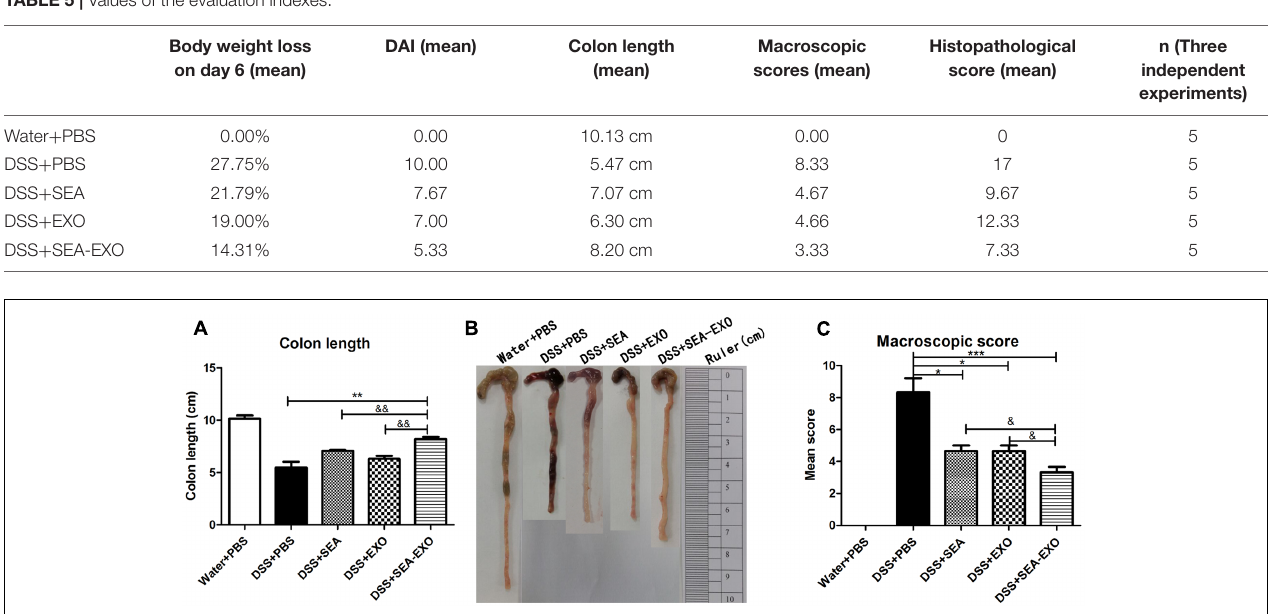
FIGURE 2 | Clinical scores of acute DSS-induced colitis mice treated with exosomes. (A) The effect of exosomes on the body weight of mice (50 µ g/mouse). Mice were weighed daily. (B) The effect of exosomes on the DAI. The DAI was evaluated using the parameters of weight loss, diarrhea, and bleeding. Statistical analyses were performed using a one-way ANOVA followed by Dunnett’s multiple comparison post hoc test ( ∗ P < 0.05, DSS+SEA-EXO versus DSS+PBS). TABLE 5 | Values of the evaluation indexes.